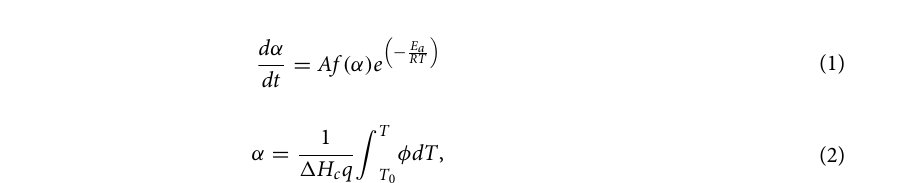
Figure 2. FTIR spectra of as-prepared Ge 15 Sb 40 S 15 Se 15 Te 15 glass. The glass is transparent within 2–12 μm wavelengths range. The insert shows transmission in the fundamental optical absorption edge